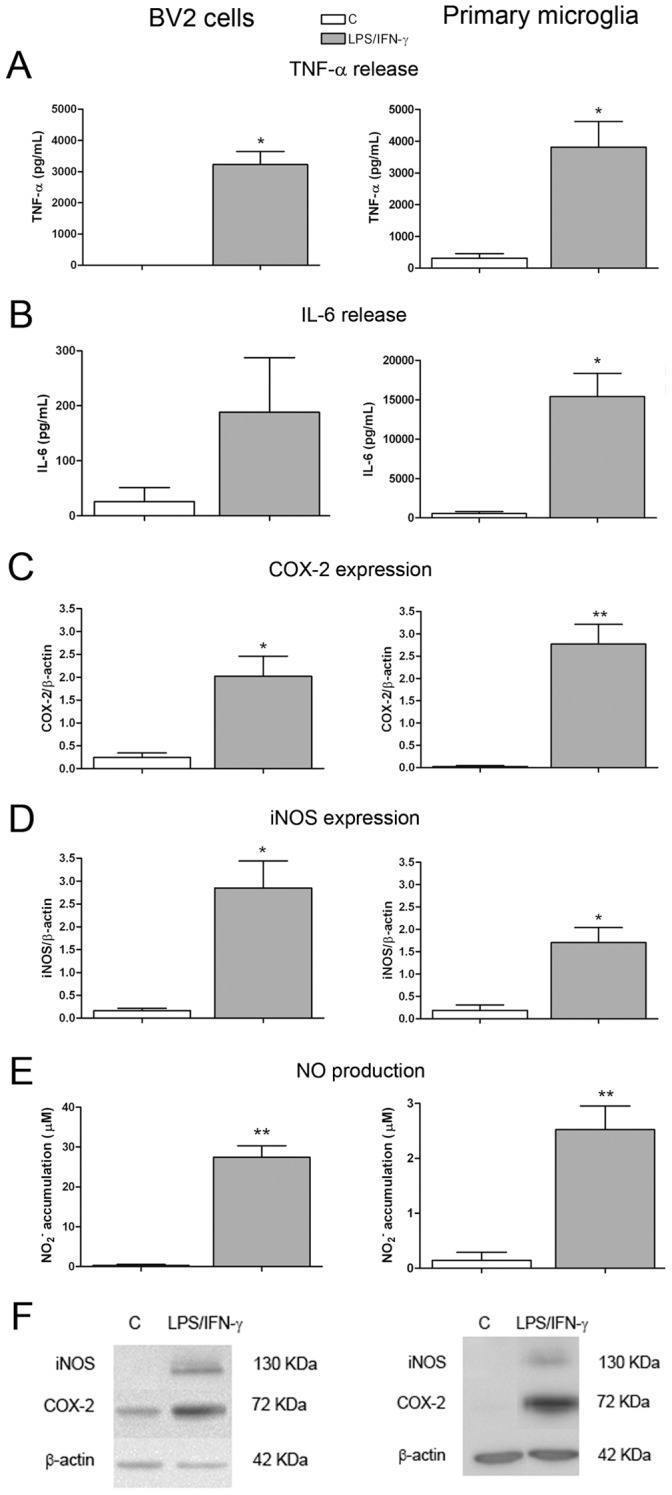
Pro-inflammatory response in BV2 and primary microglia cell cultures in response to LPS/IFN-γ.BV2 cells were treated 100 ng/mL of LPS +0.5 ng/mL of IFN-γ and primary microglial cells with 100 ng/mL LPS +30 ng/mL IFN-γ, and different pro-inflammatory parameters were measured. TNF-α (A) and IL-6 (B) levels were determined in the culture medium 24 h after treatment. COX-2 (C) and iNOS protein expression (D) were measured by western blot 12 h after treatment, and data normalized by β-actin. NO production (E) was determined in the culture medium 24 h after treatment. Bars are means + SEM of four to six independent experiments. *p<0.05 and **p<0.01 vs control; paired Student’s t test. (F) shows representative western blots.